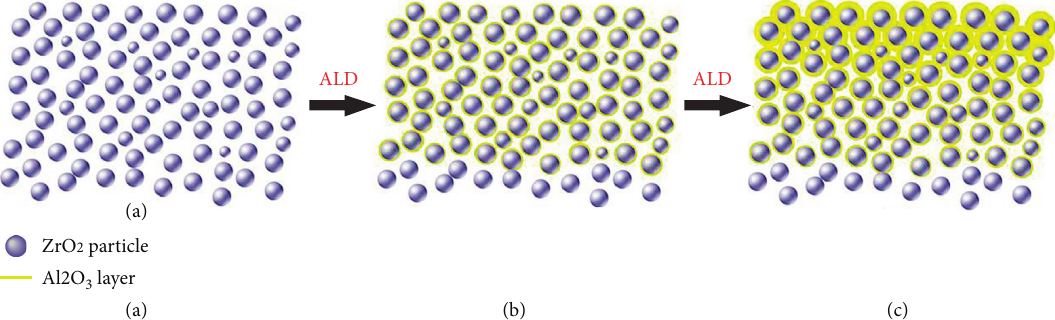
Figure 16: Schematics of pore tailoring by ALD of alumina over zirconia: (a) pristine membrane before ALD operation; (b) application of ALD; (c) increasing alumina thickness with increasing ALD cycles [76].